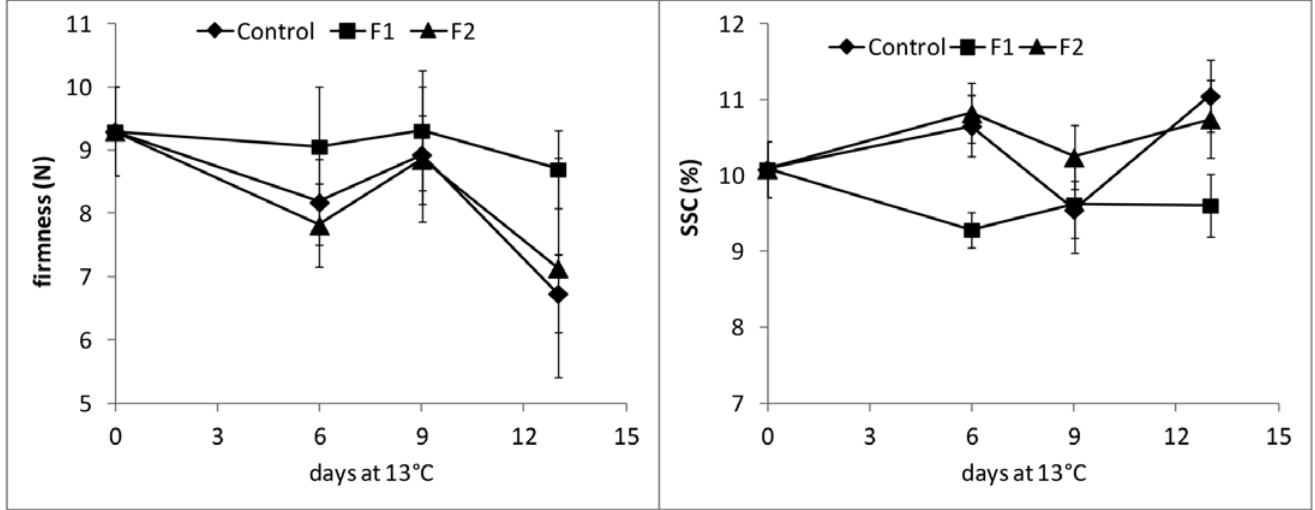
Fig. 2 - Firmness (left) and soluble solids content (SSC, right) of control and coated (F1, F2) melon fruit during storage at 13°C. Bars refer to stan- dard error of the mean (n=6).